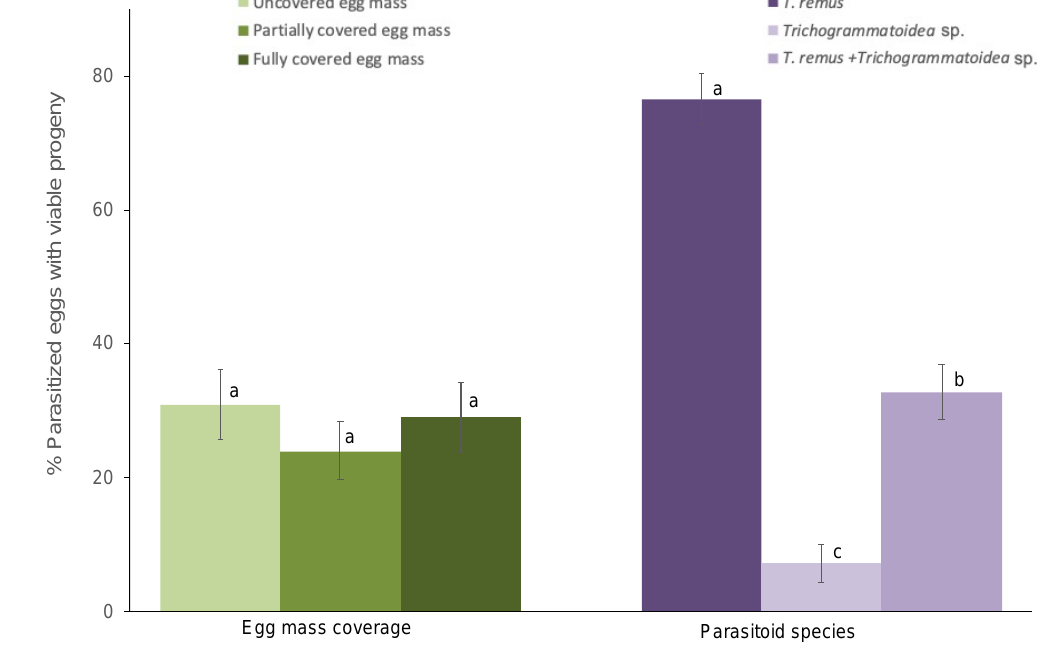
Figure 2. Viable progeny emerging from eggs of Spodoptera frugiperda (% ± SE) parasitized by T. remus , Trichogrammatoidea sp., and combined T. remus + Trichogrammatoidea sp. of fully covered, partially covered, and uncovered egg masses. Bars bearing different letters within column groups were significantly different (Bonferroni test, α = 0.05).